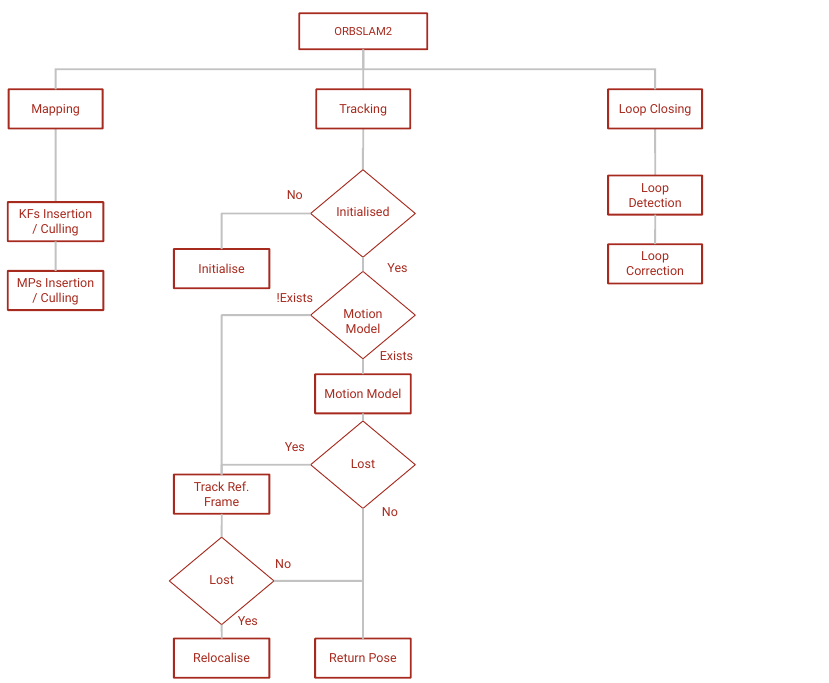
Figure 1. The architecture of ORBSLAM2 [5]. “KFs” means keyframes, “MPs” map points and “ref” means